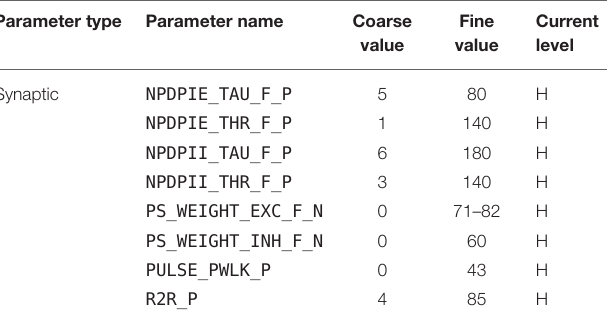
TABLE 5 | Bias parameter values used for the feature detecting neuron, LN4, in the DYNAP-SE implementation of the cricket feature detection network. Parameter type Parameter